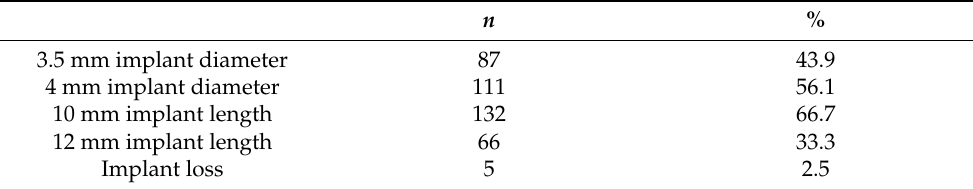
Table 2. Description of the width and length of the implants placed and the percentage of implants lost. The 5 lost implants are distributed: 2 of 3.5 mm diameter and 3 of 4 mm, with p = 0.629 and 4 of 10 mm in length and 1 of 12, with p = 0.703. n